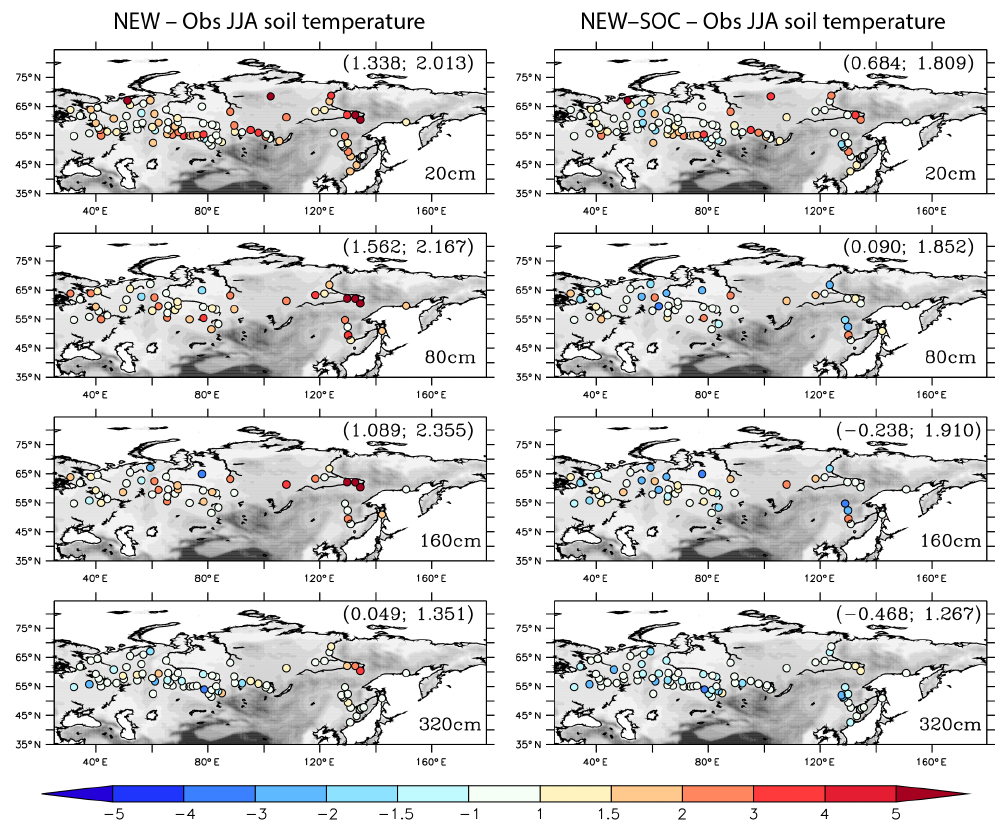
Figure 11. Monthly soil temperature profile bias simulated by the NEW (left panels) and the NEW-SOC (right panels) experiments during summer and expressed in degrees Celsius. Total skill scores (bias; c-rmse) are given in the top panel for each soil